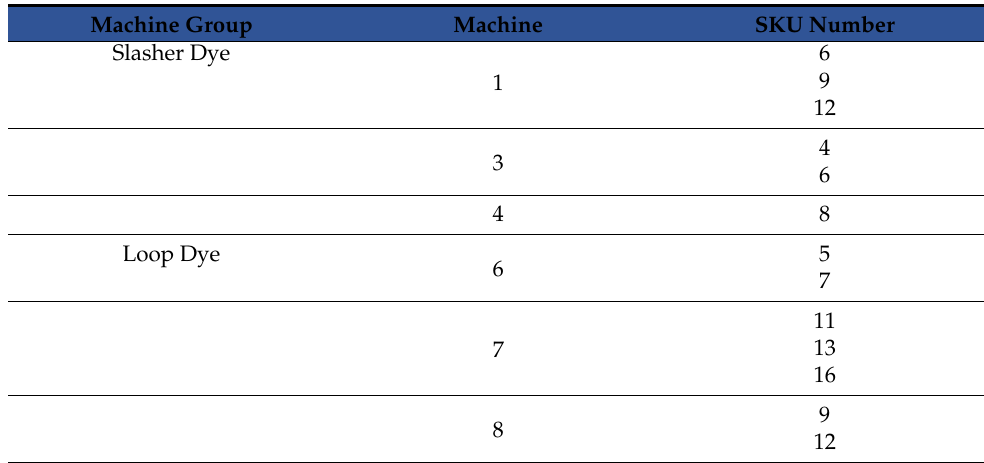
Table 2. SKU numbers were chosen to